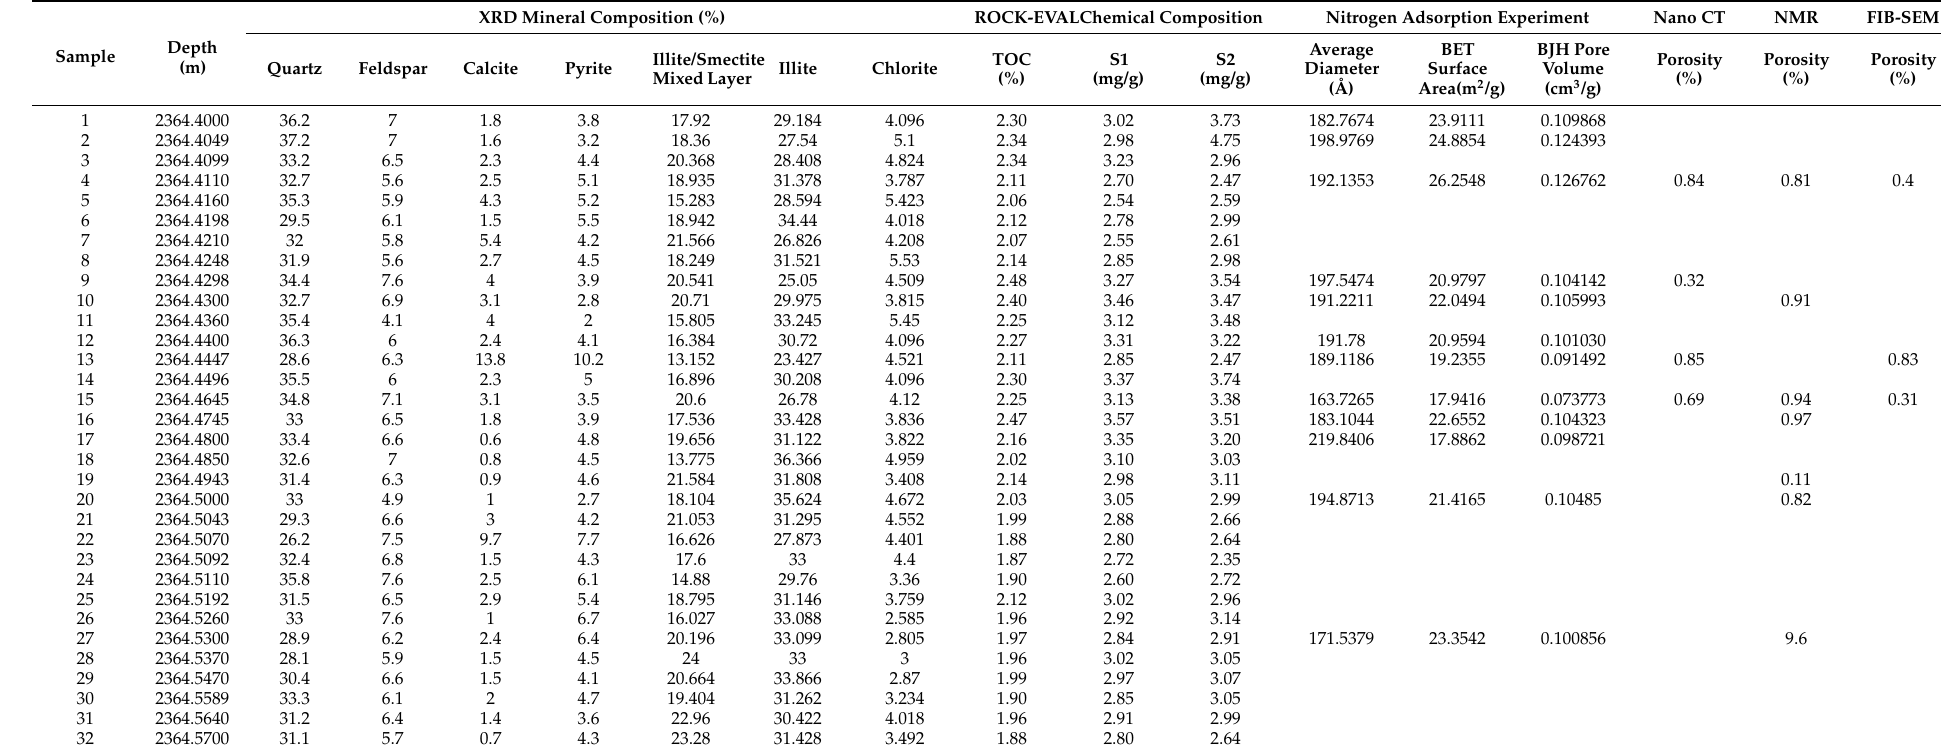
Table 1. Chemical compositions, mineral compositions, and pore structure data for the 32